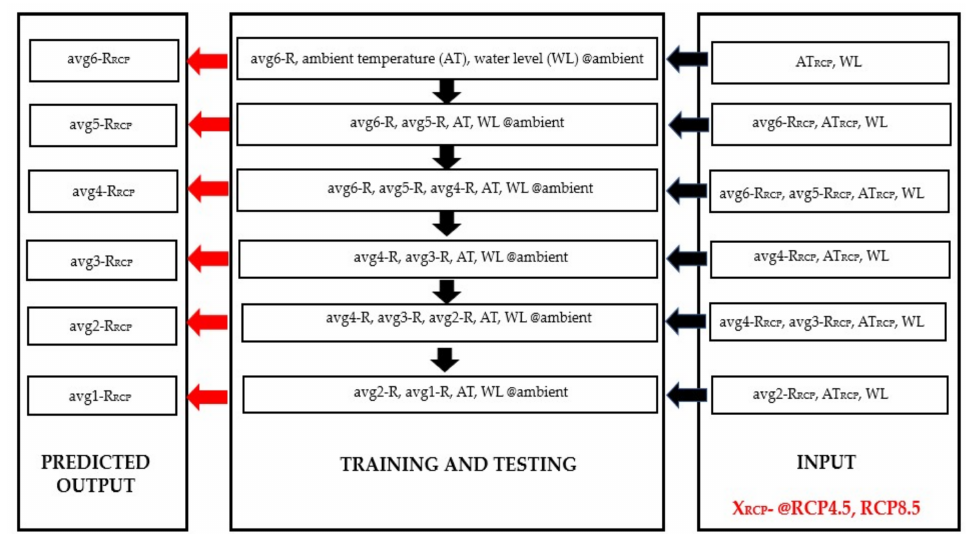
Figure 33. Methodology for predicting water temperatures.